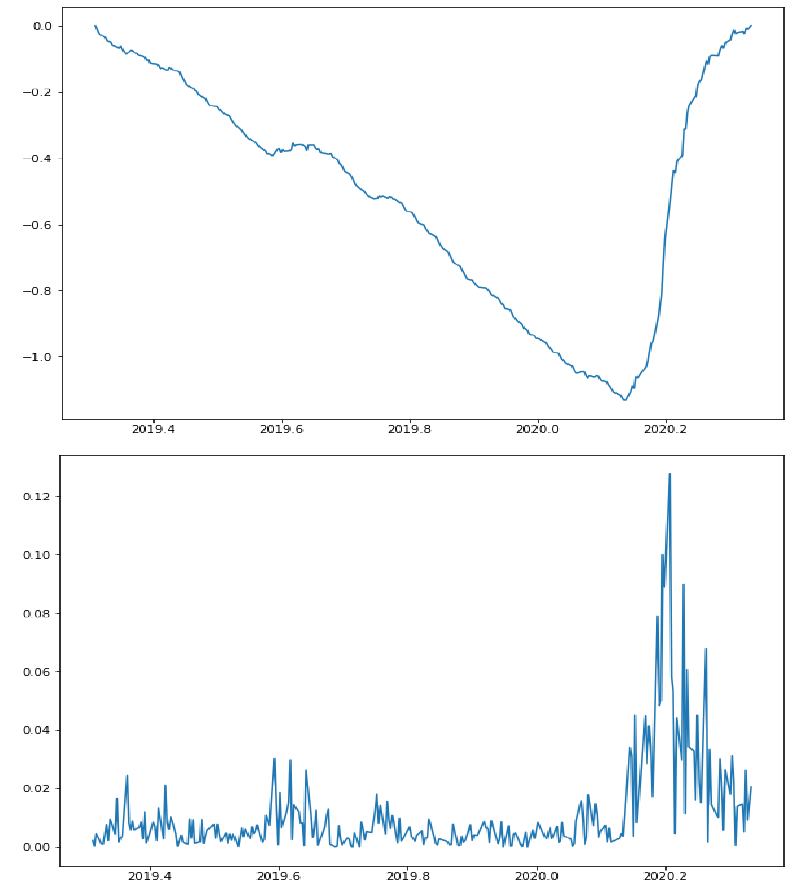
Figure 2. The graph at the top depicts the volatility series of the S&P500 index in the period ranging from March 2019 to March 2020. On the other hand, the chart at the bottom shows the series of absolute values of the log-returns of the S&P500 in the same period. That period, the self-similarity index of the volatility series of the S&P500, was found to be equal to 0.94 by the FD4